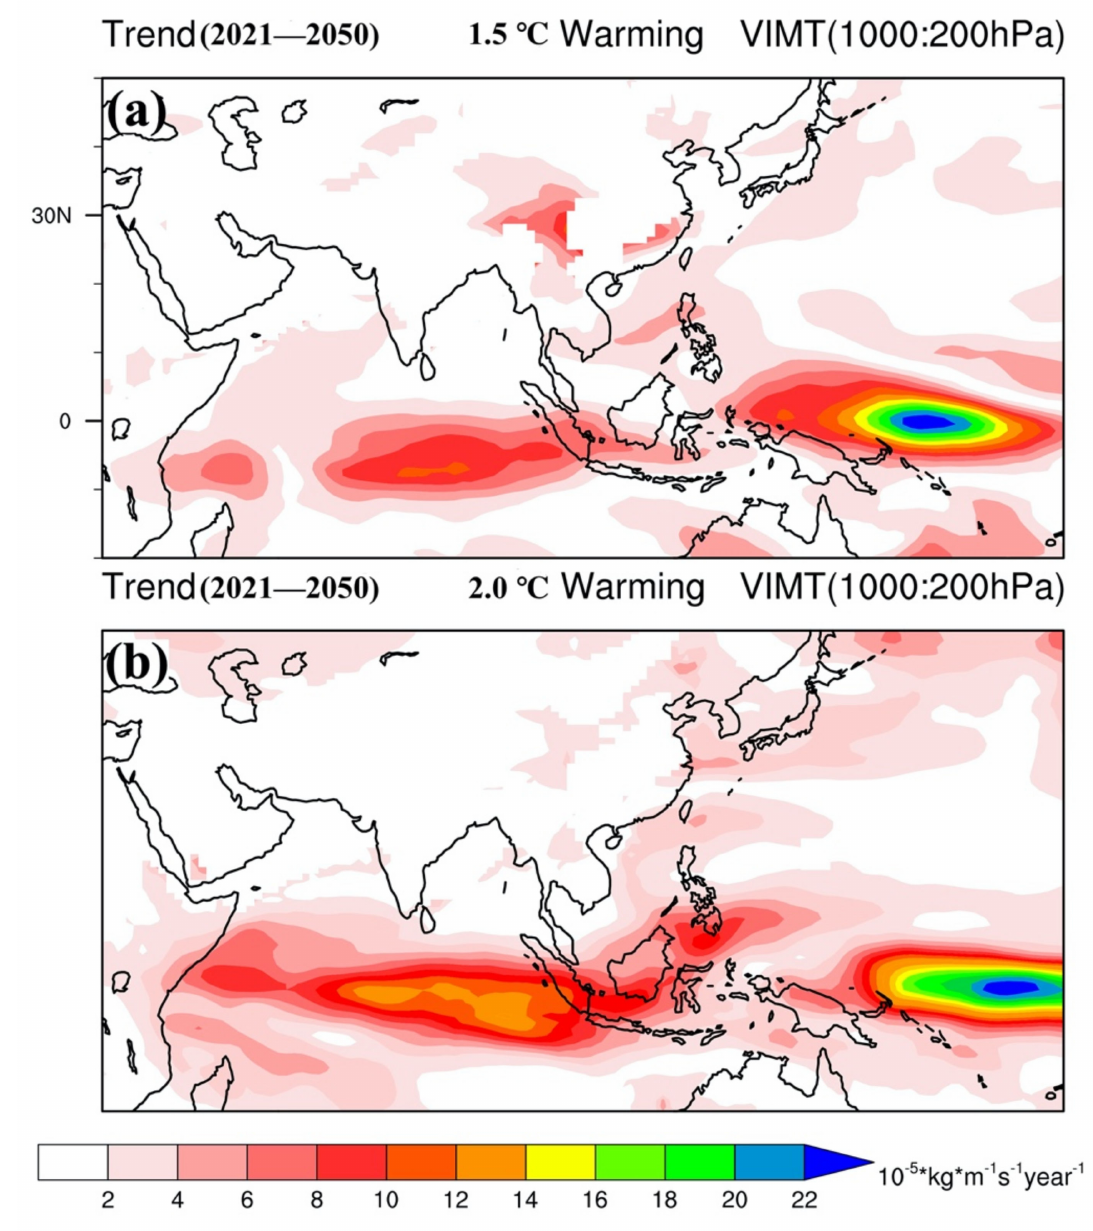
Figure 3. Ensemble JJAS trend (2021–2050) of vertically integrated moisture